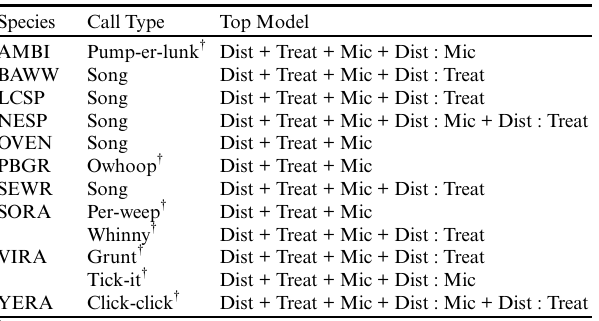
Table 2 . Top binomial regression models for 12 species call types Table 3 . Effective detection radius in meters for ten species (and based on model rankings obtained using Akaike’s information 12 calls) under three levels of environmental noise (dBA) and for criteria corrected for small sample size (AIC ). Models include microphones 0, 5, 10, 15, and 20 dBV below our measured c distance to the sound source (Dist), noise treatment (Treat), manufacturer sensitivity specifications. Species include American microphone sensitivity loss (Mic), and relevant interactions. Bittern (AMBI), Black-and-white Warbler (BAWW), Le Conte’s Sparrow (LCSP), Nelson’s Sparrow (NESP), Ovenbird (OVEN), Pied-billed Grebe (PBGR), Sedge Wren (SEWR), Sora (SORA; per-weep and whinny calls), Virginia Rail (VIRA; grunt and tick- it calls), and Yellow Rail (YERA). Results omit species/noise combinations where predicted effective detection radii were beyond the range of measured distances in our experiment. Noise